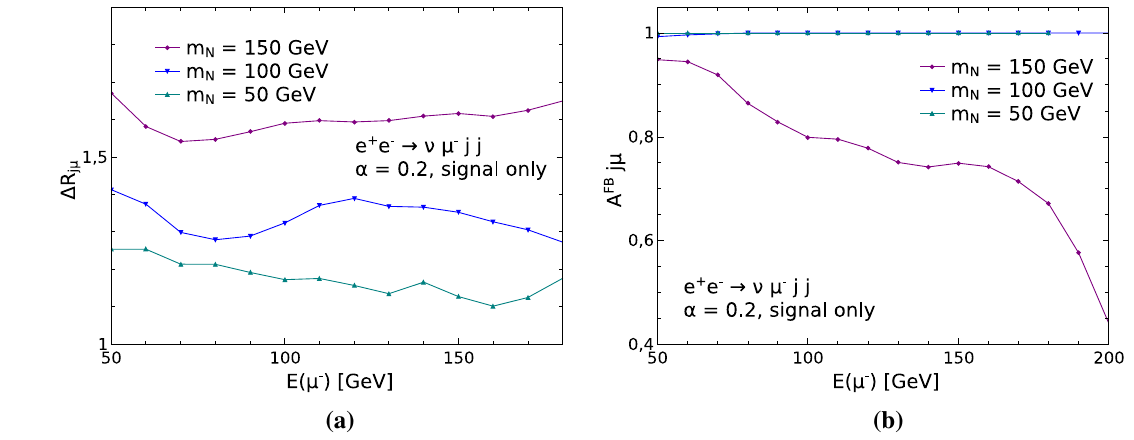
Fig. 5 Average (cid:15) R j μ ( a ) and A FB